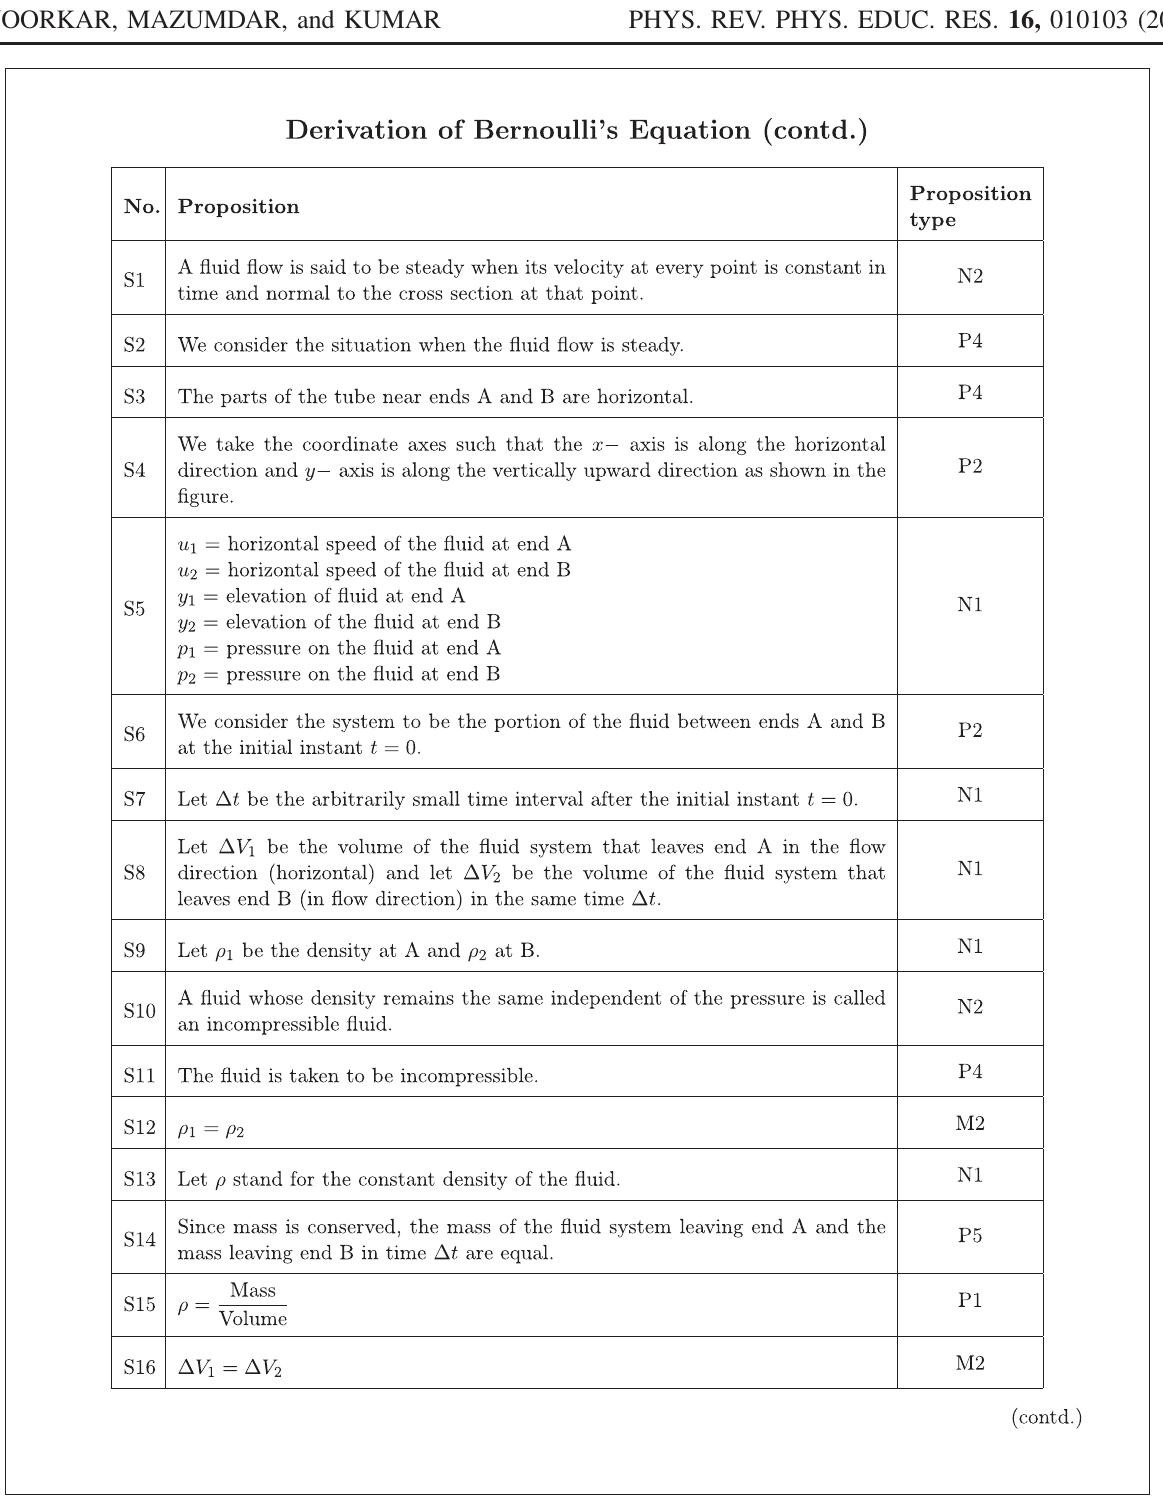
FIG. 17. Diagnostic tool for epistemic understanding: (IV) Derivation of Bernoulli ’ s equation (part 2). Note: Expert answers have been filled in this table. Next part of the tool in Fig.